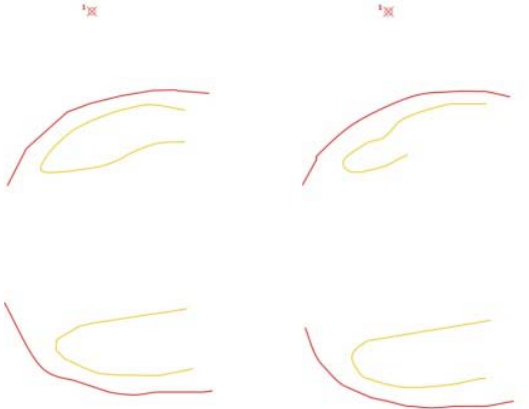
Figure 5: Analysis results of the GPR data (2D sections) for heights 0.30m, 0.70m and 1.20m